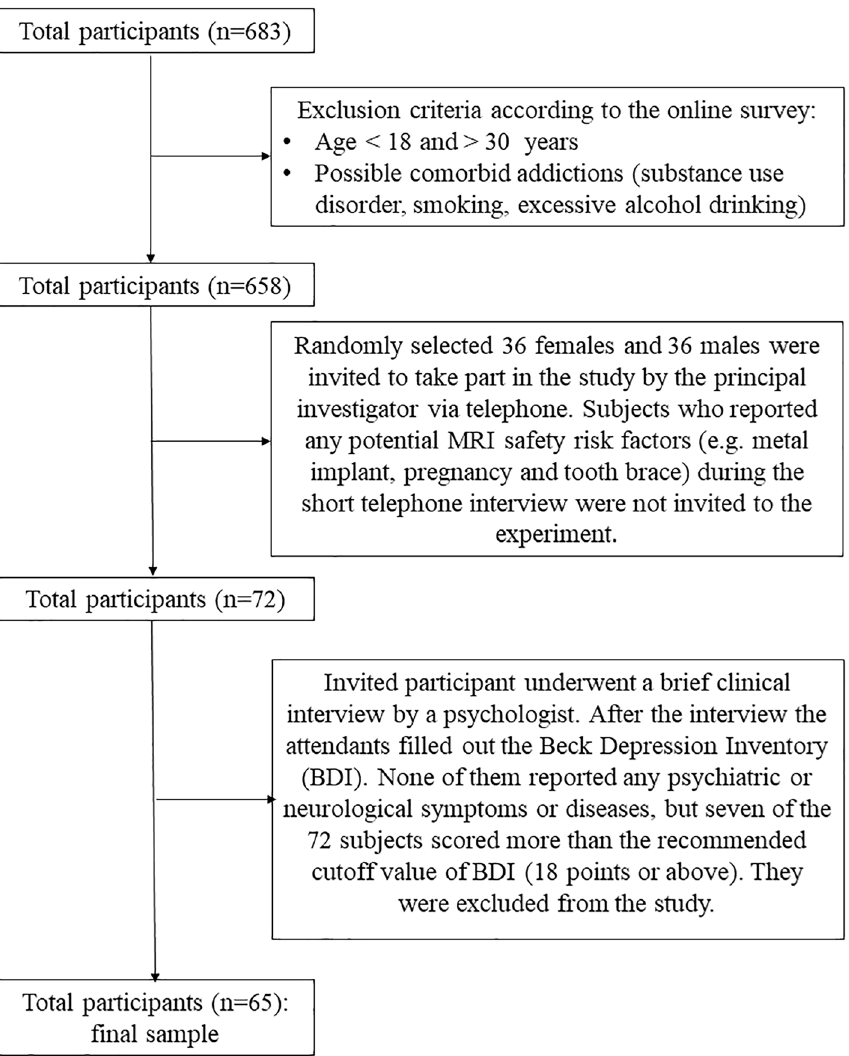
Figure 1. Selection of the final sample. A total of 683 participants completed the online survey, 25 of them reported smoking habits. They were excluded from the selection procedure. All candidates met the expected age range (18–30 years). From the remaining 658 participants 36 females and 36 males were chosen randomly with no MRI safety risk factors. Seven of the 72 subjects scored more than the recommended cutoff score of BDI, therefore they were excluded. Finally, 65 participants took part in the